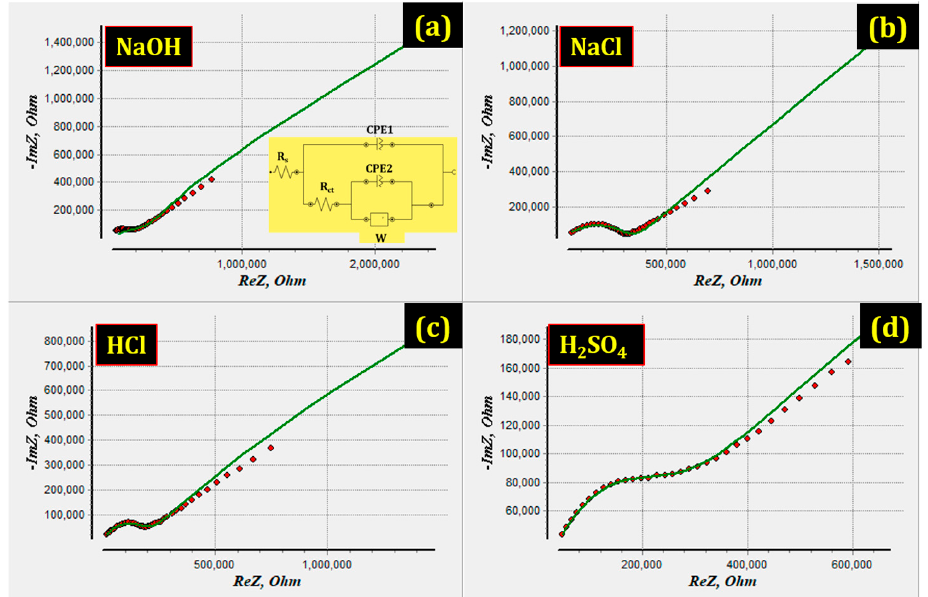
Figure 5. EIS Nyqist plots of 17.5%B4C/Al-Mg-Si AMCs obtained in various environments.